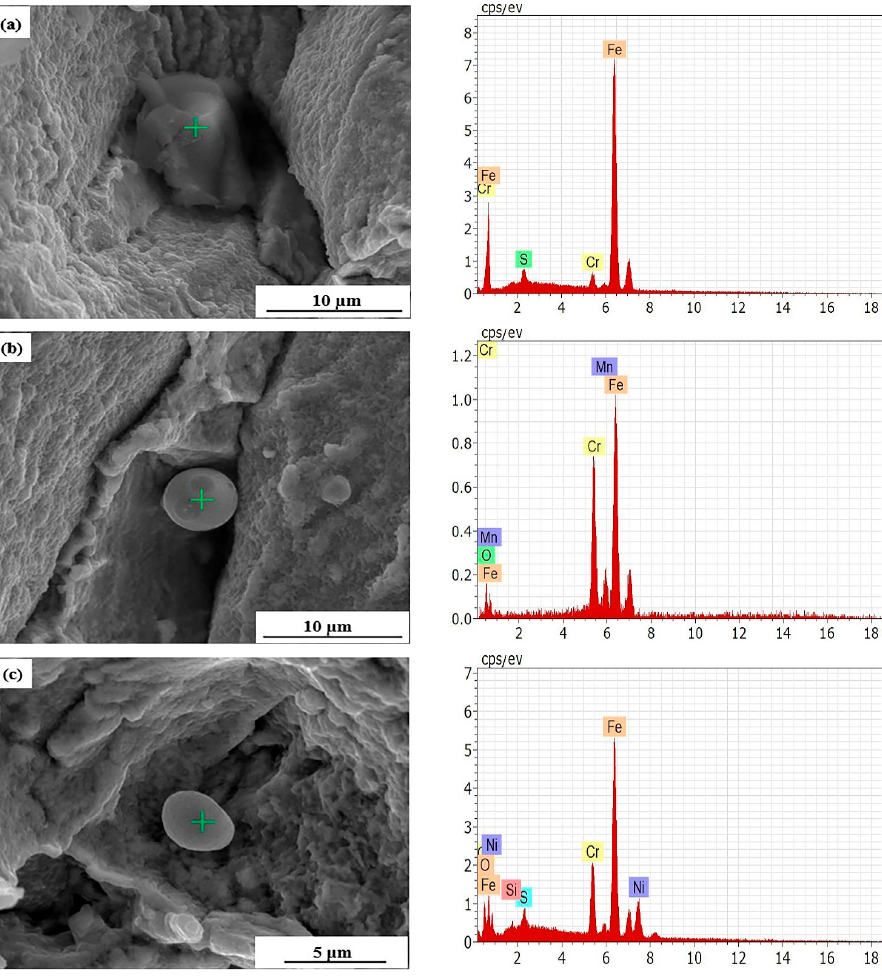
Figure 6. EDS analysis of particles at the tensile fracture: ( a ) 800 °C, 9500 × , ( b ) 900 °C, 10,000 × , ( c ) 1000 °C, 15,000 × .